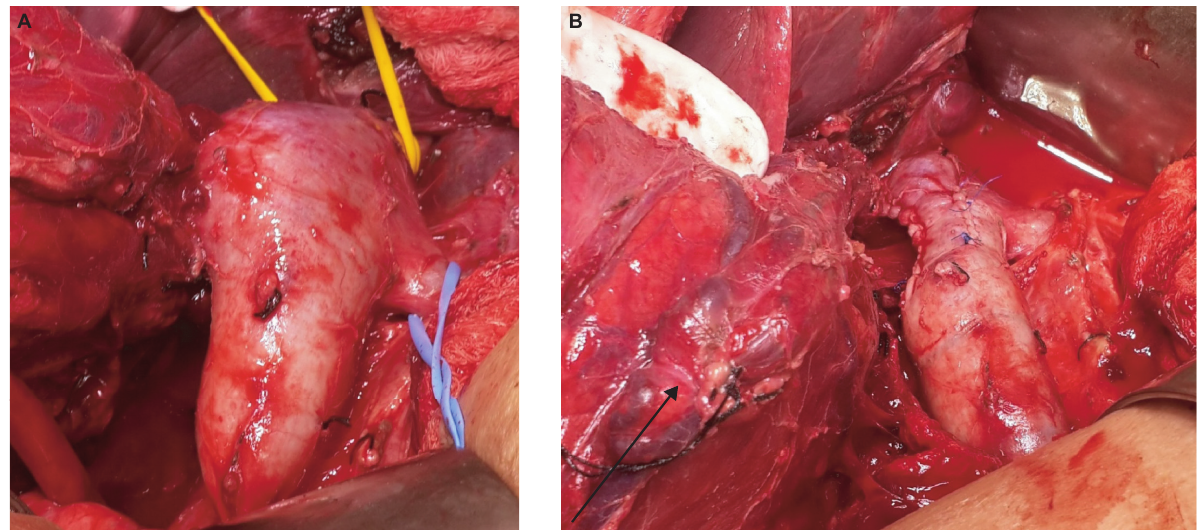
Figure 2: (A) Level 2 thrombus with proximal, distal and left renal tourniquet. (B) Completion of tumor thrombectomy with renal mass (arrow) in